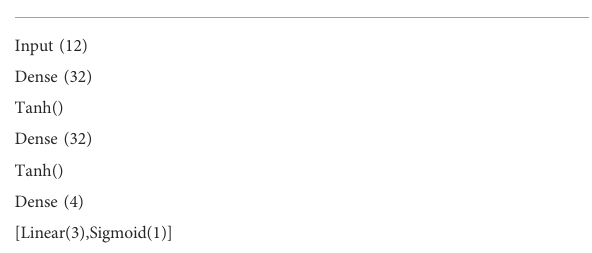
TABLE 3 Policy network architecture for the bookcase task.